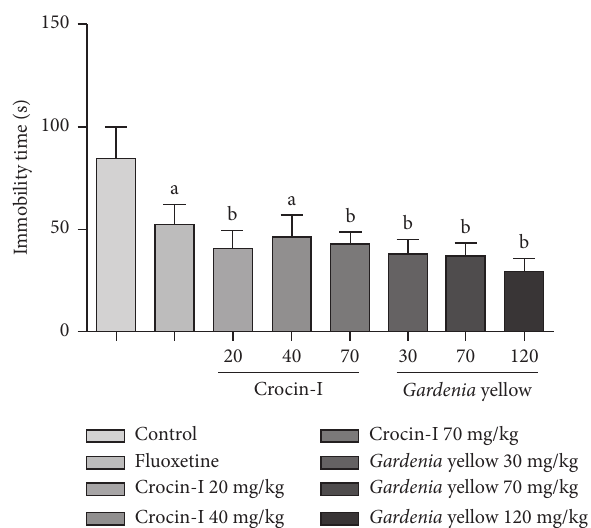
Figure 5: Effect of crocin-I (20, 40, and 70 mg/kg, i.g.) and Gardenia yellow (30, 70, and 120mg/kg, i.g.) on the total duration immobility time in the force swimming tests of mice. The data were expressed as mean ± SEM of 11 mice in each group; a p < 0 . 05 and b p < 0 . 001 vs control group. Positive control mice were treated with fluoxetine